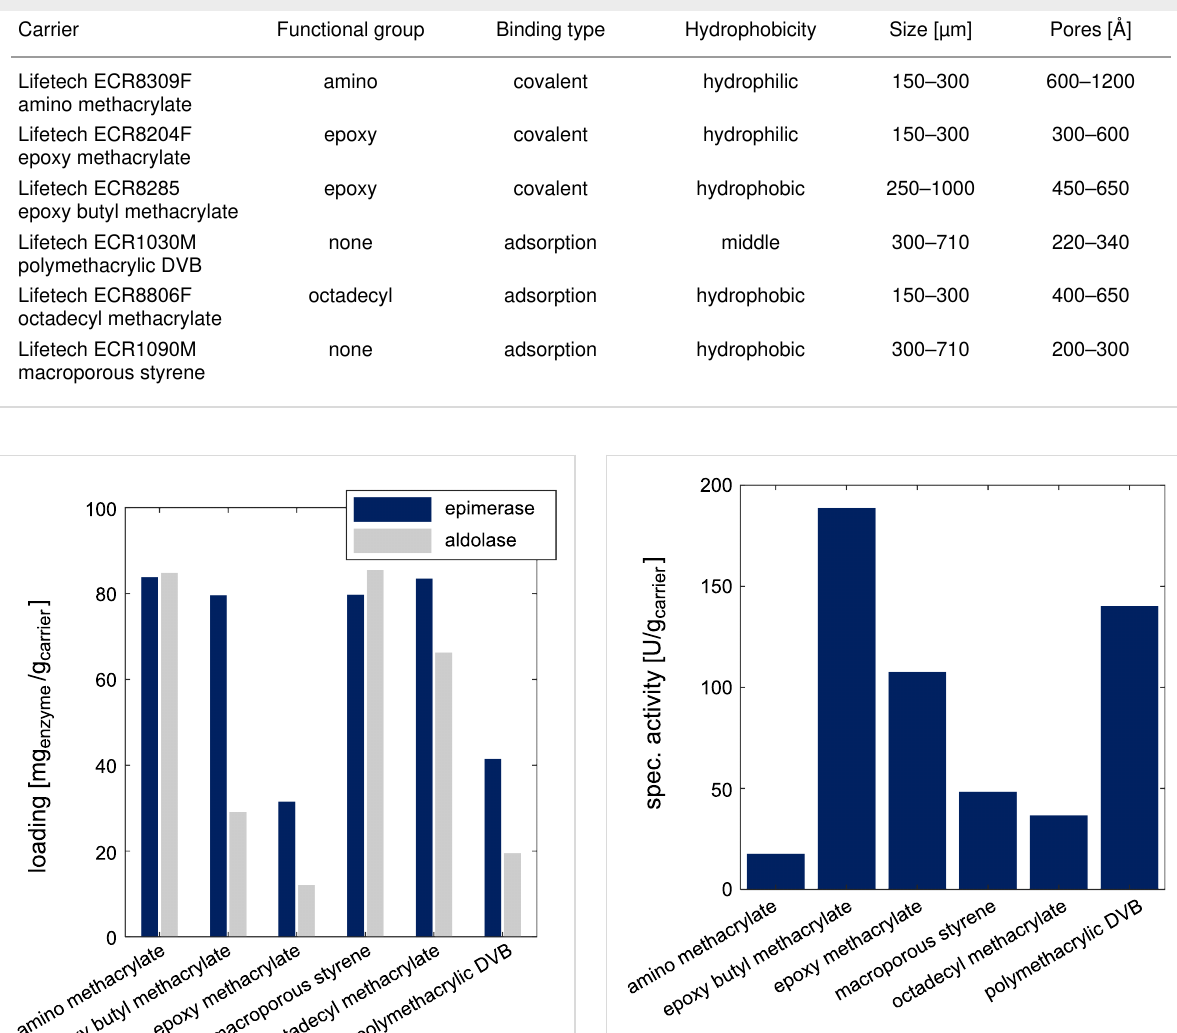
Table 1: List of carriers used for the screening in this work (Lifetech Purolite).